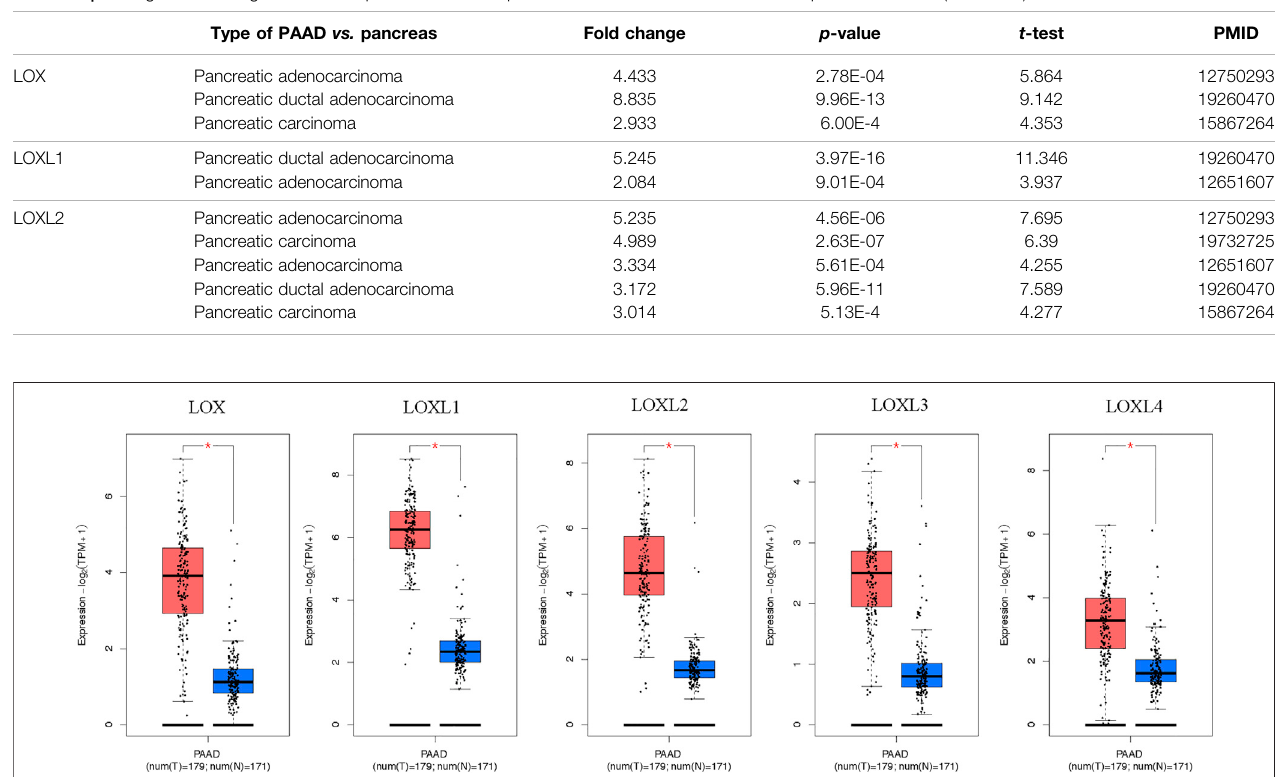
FIGURE 2 | Boxplot showing the expression levels of LOXs in PDAC. The mRNA expression of LOXs was signi fi cantly elevated in PDAC than normal pancreas tissues (GEPIA database). The number of normal samples is 171 (blue box), and PDAC samples are 179 (red box), red star means p < 0.01.